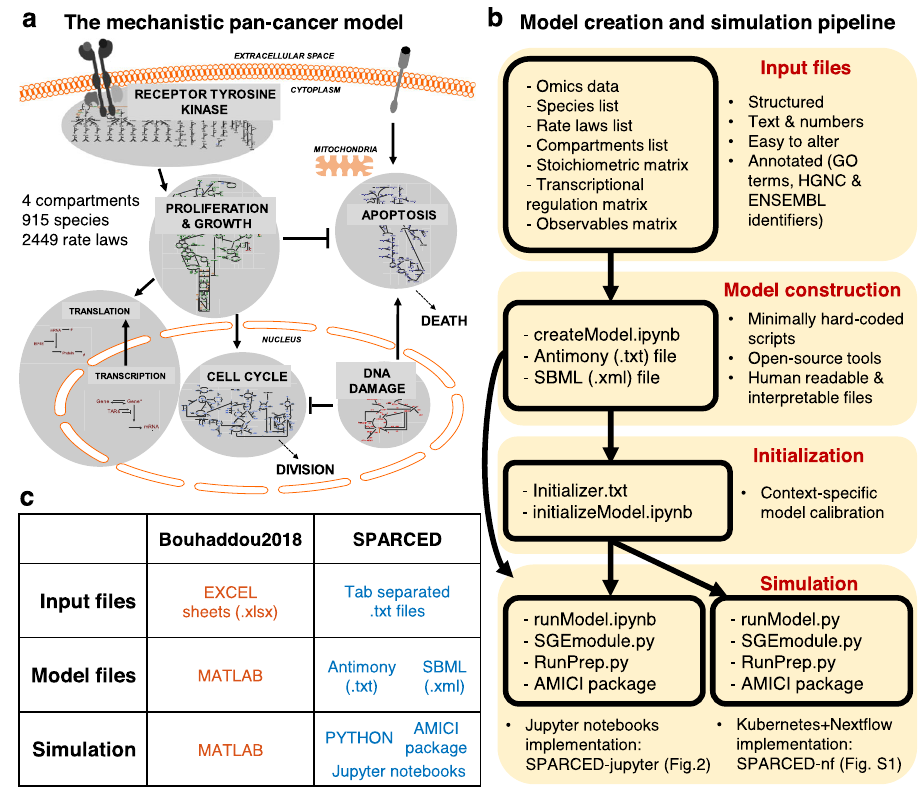
Fig. 1 SPARCED is a structured, human interpretable, and easy to modify big mechanistic model. a The schematic of the underlying model for SPARCED. Image adapted from 40 . b The pan-cancer mechanistic model Bouhaddou2018 is re-written in open-source and structured fi le format. The steps of model construction include input fi le creation and conversion into an SBML fi le. The optional initialization step calibrates model parameters for new cellular contexts and phenotypic behaviors. The annotated SBML model fi le and stochastic module are simulated together at single-cell level locally or by using cloud-computing. The bene fi ts of the new SPARCED model include easy alteration and expansion capabilities through text fi le editing, human-readable annotated input fi les, and use of Jupyter notebooks for model creation and simulation. The modeling pipeline introduced here are inline with good practices of re-usable big mechanistic models 57 . c The Bouhaddou2018 model fi le types are simpli fi ed and converted into open-source